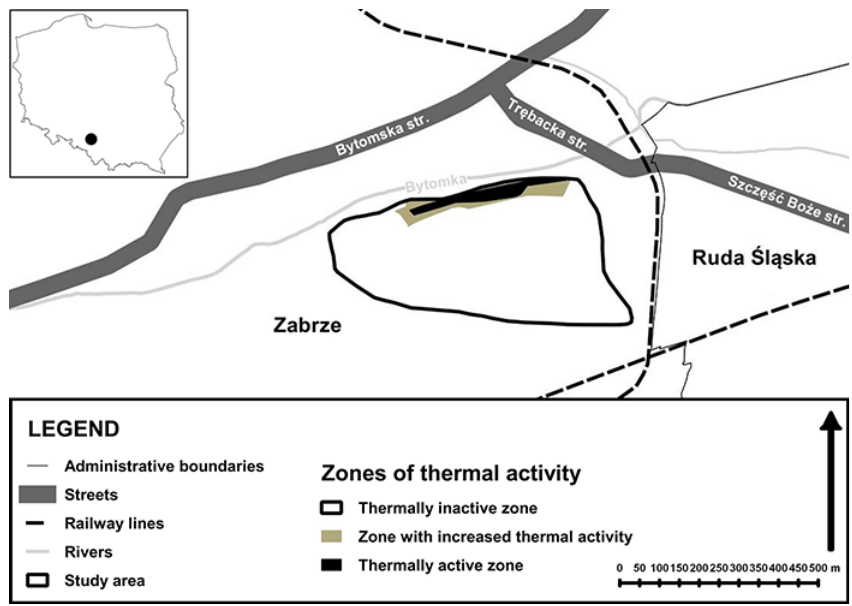
Fig. 1 Map of the thermal activity of the postmining “Ruda”